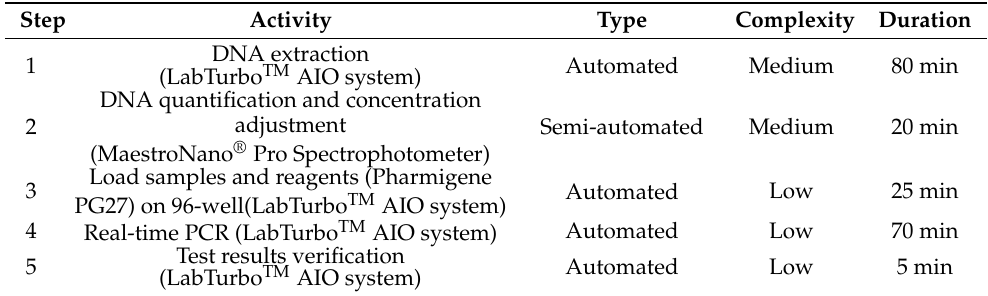
Table 3. Sequential flow of automated steps and the time required for each step in the detection of